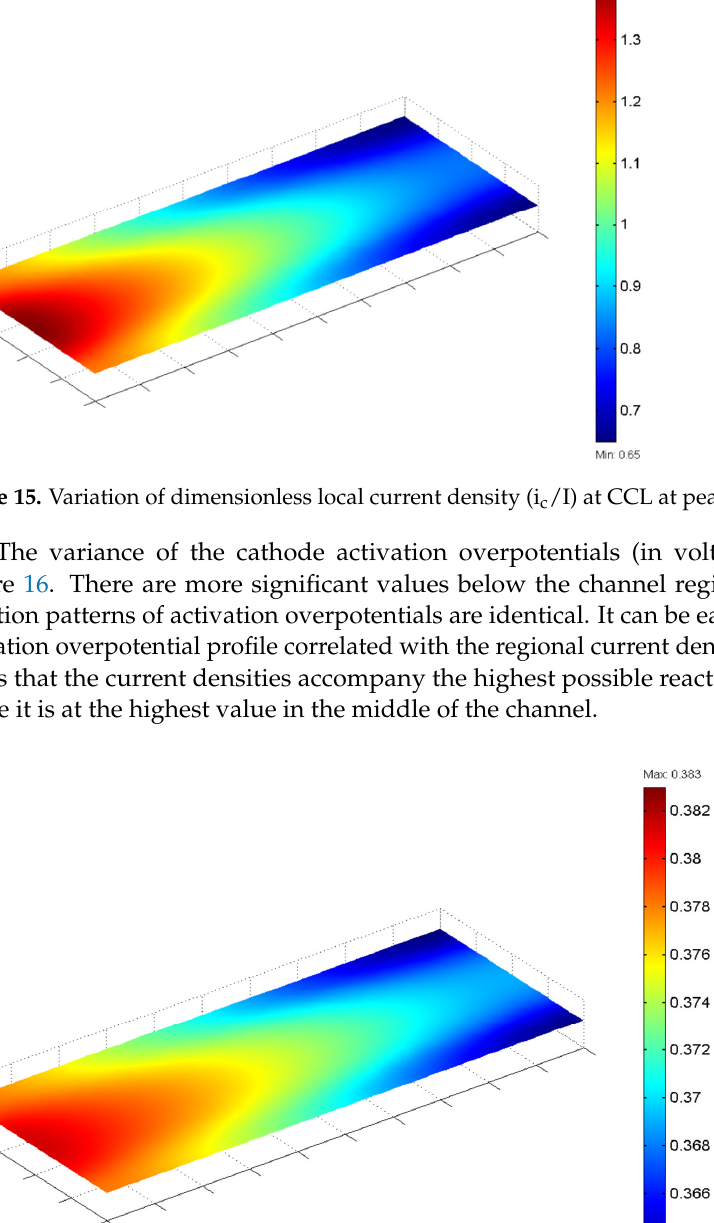
Figure 14. Temperature profile within the cell at peak power.